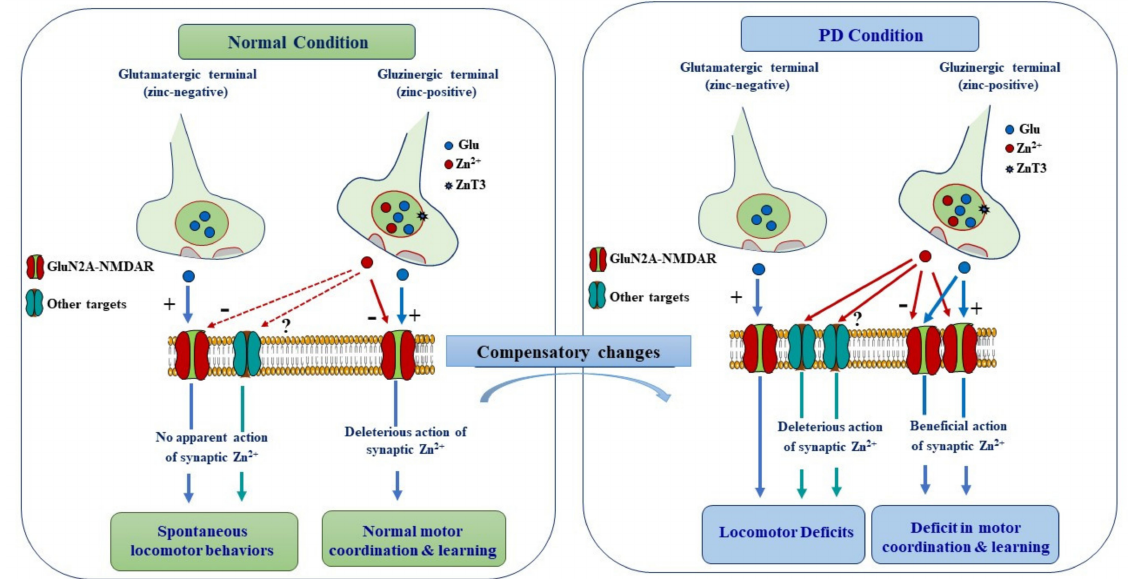
Figure 6. Schematic diagram summering the proposed mechanisms underlying synaptic modulation of motor function in normal and PD conditions. Vesicular Zn 2+ is present in a subset of cortico-striatal pathways and thus contributes to the modulation of a specific aspect of motor behavior. In normal condition, synaptically released Zn 2+ from cortico-striatal gluzinergic terminals does not seem to modulate spontaneous locomotor behavior. By contrast, it negatively modulates learning of motor skills by dampening the activity of GluN2A-NMDARs. In PD condition, synaptically released Zn 2+ is recruited and plays a deleterious role alongside glutamate by promoting the expression of locomotor deficits. However, the detrimental modulatory action of Zn 2+ is mediated by other targets than NMDARs, which become accessible to Zn 2+ owing to the profound morphological changes that take place upon DA depletion. In the context of DA depletion, Zn 2+ action on GluN2A-NMDARs is rather beneficial because the aberrant increase in NMDAR signaling impairs motor